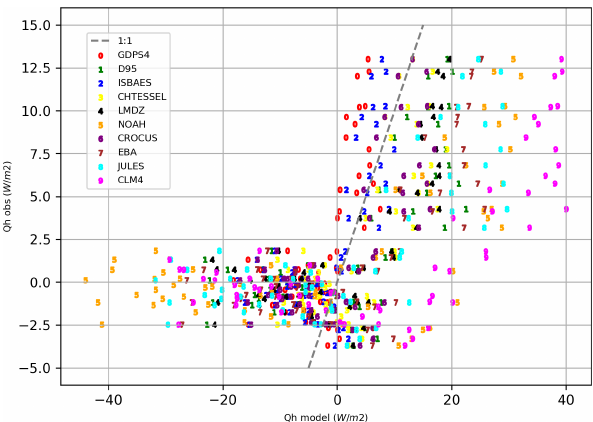
Figure 9. Scatterplot of sensible heat flux simulated ( x axis) and measured ( y axis). The dashed gray line represents the 1 : 1